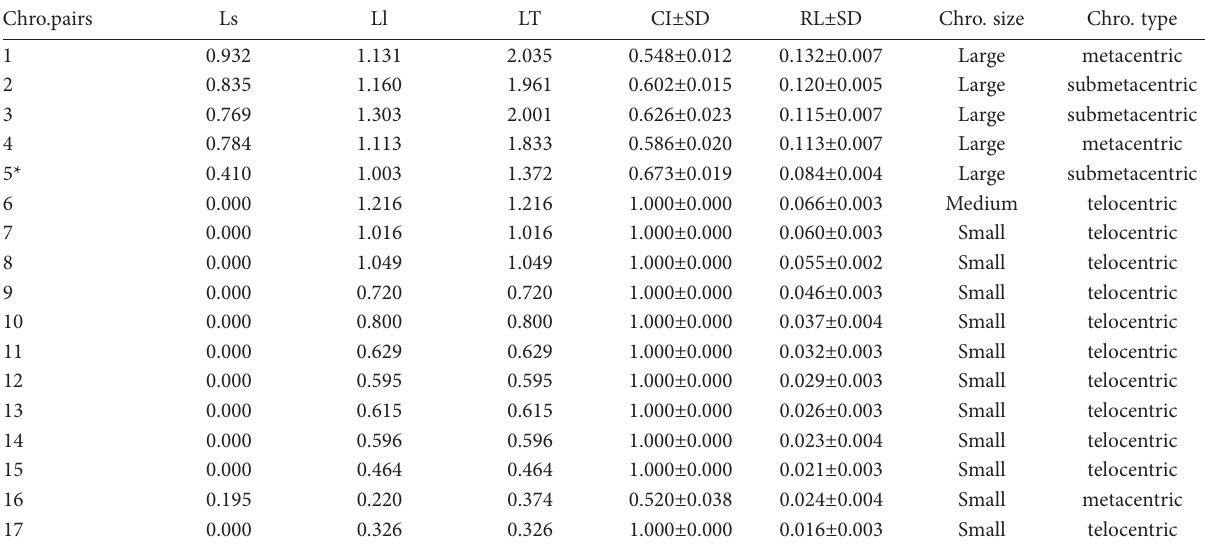
Table 2. Mean length of short arm chromosome (Ls), length of long arm chromosome (Ll), length of total chromosomes (LT), relative length (RL), centromeric index (CI), and standard deviation (SD) from 20 metaphases of male and female Red-eyed Gecko ( Gekko nuta- phandi ), 2 n (diploid)=34.